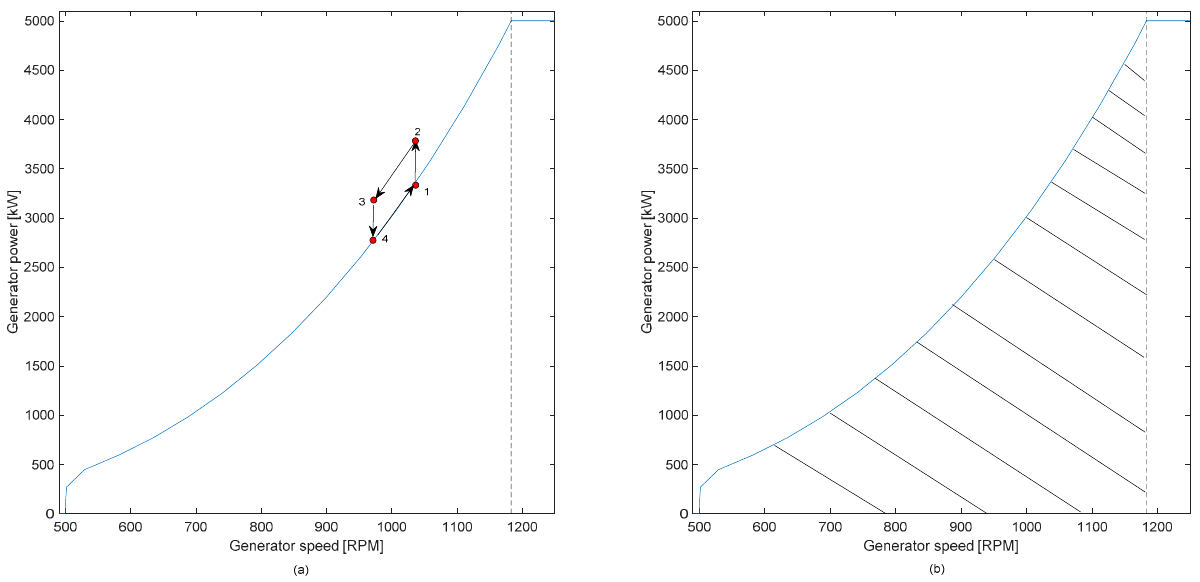
Figure 4. Power ‐ vs ‐ speed characteristic (blue line) of the NREL 5 MW wind turbine (WT) [23]. ( a ) The black quadrangle depicts the transient behavior of the WT when supplying SI. ( b ) The black shaded area depicts typical operating points of the WT when operating in curtailed mode with the simulated PFC controller.